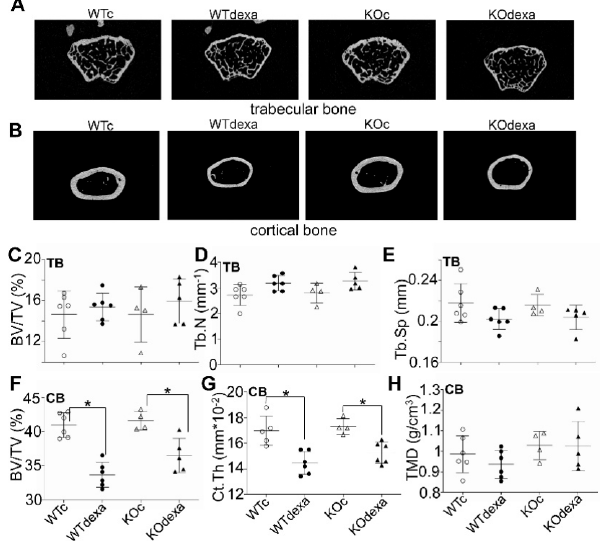
Figure 4. MicroCT analysis of distal femurs in male mice. Representative 2D longitudinal microCT images of ( A ) trabecular bone at the metaphyseal region in distal femurs and of ( B ) cortical bone at the diaphysis region of distal femurs from each each experimental group. Quantitative analysis of the trabecular bone in the metaphysis region of the distal femurs in male mice: ( C ) BV/TV (bone volume/total volume, %), ( D ) Tb.N (trabecular number per mm), ( E ) Tb.Sp (trabecular separation, mm). Quantitative analysis of midshaft cortical bone of femurs from each group with microCT: ( F ) BV/TV (bone volume/total volume, %), ( G ) Ct.Th (cortical thickness, mm), ( H ) TMD (Tissue mineral density, g/cm 3 ). * p < 0.05 of the indicated comparison. WTc: wild-type control (vehicle- treated); KOc: Nrf2 knockout control (vehicle-treated); WTdexa: wild-type dexamethasone-treated; KOdexa: Nrf2 knockout dexamethasone-treated. TB: trabecular bone. CB: cortical